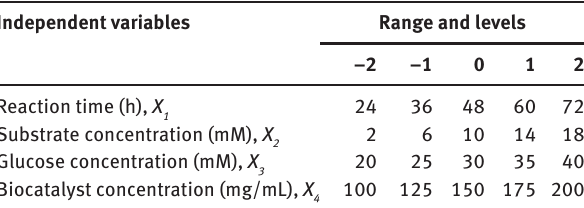
Table 1: Experimental range and levels of independent